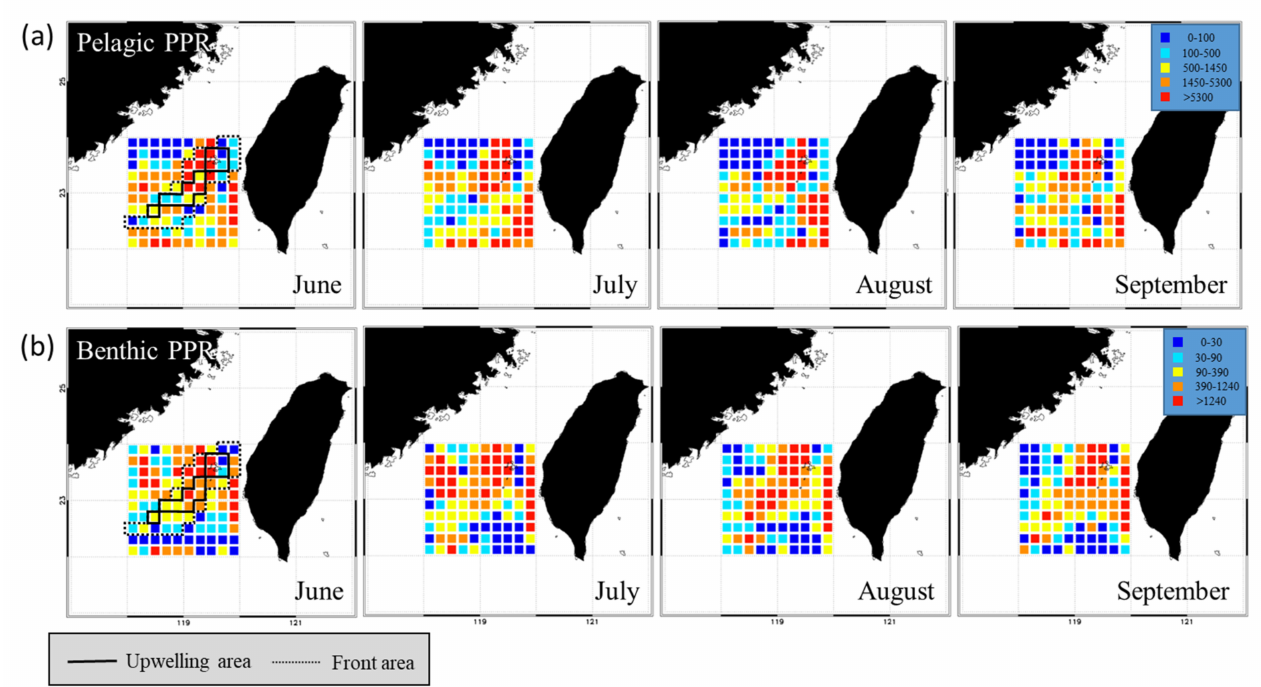
Figure 5. Spatial distributions of monthly data for ( a ) pelagic primary production required (PPR) and ( b ) benthic PPR in the Taiwan Bank region (2011–2016). The areas circumscribed by solid and dotted black lines are the upwelling and thermal front habitats, respectively.